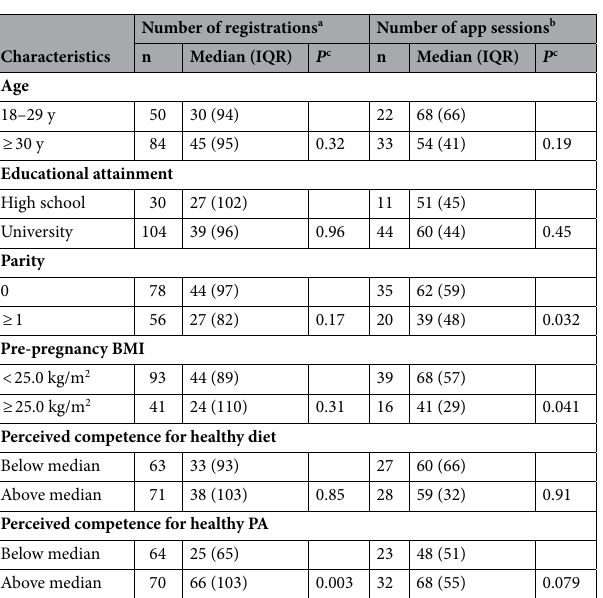
Table 2. Differences in app user engagement according to characteristics of the women. IQR Interquartile range, BMI Body mass index, PA Physical activity. a Refers to the number of registrations from the self- monitoring features for weight-, diet- and physical activity within the HealthyMoms app. b An app session represents a single period of user interaction with the app. c Refers to the P value of a Mann–Whitney U